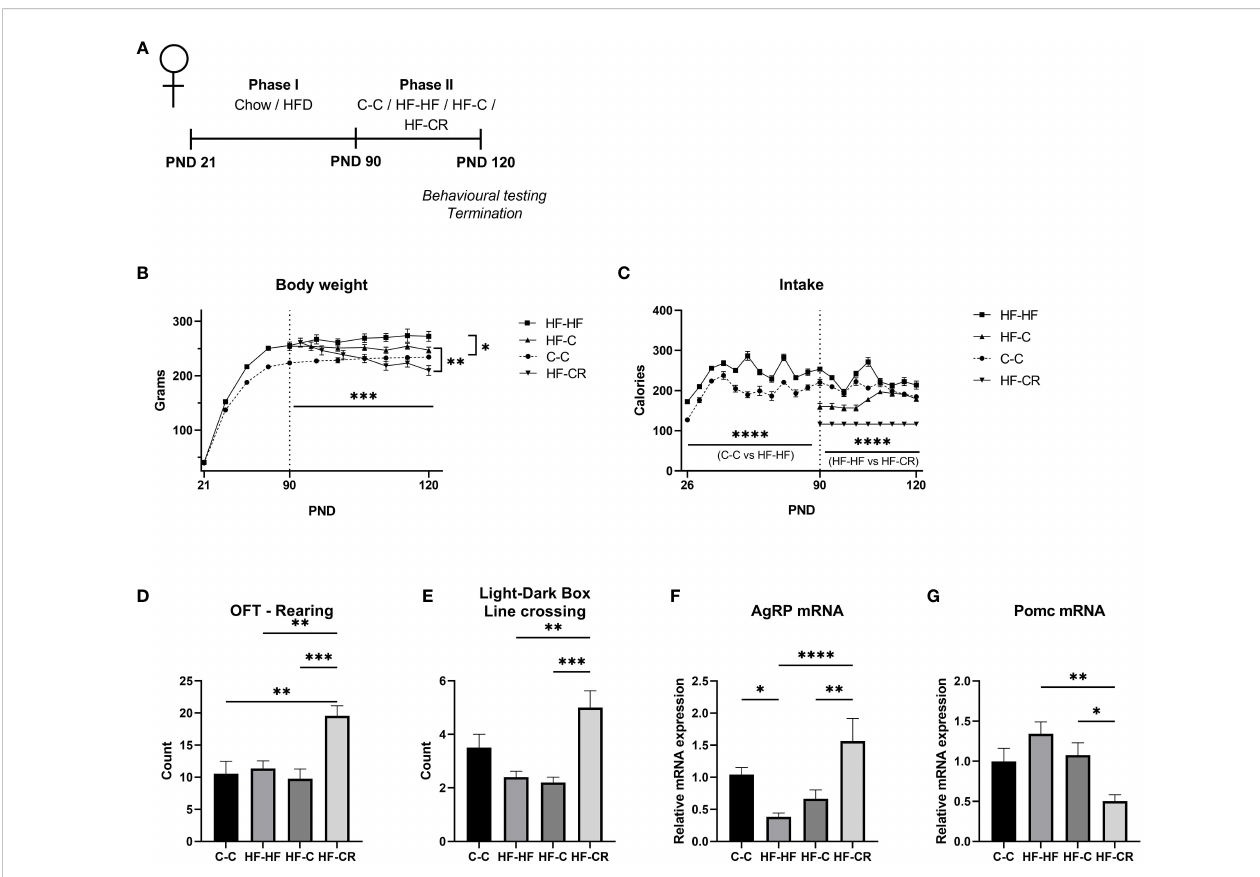
FIGURE 1 Caloric restriction results in reduction of body weight, increased explorative behaviours and changes in classic-energy balanced gene expression in the ARC of diet-induced obese female rats. (A) Experimental timeline. In Phase I (PND 21-90), rats were raised on either chow (n= 24) or HFD (n= 72). In Phase II (PND 90-120) rats were assigned to various treatment groups (n=24), with body weight normalized between the HFD groups. C-C (Chow- Chow) group maintained an ad libitum chow diet, HF-HF (HFD-HFD) group maintained an ad libitum HF diet, HF-C (HF-Chow) group switched from ad libitum chow to HFD and HF-CR (HFD-Caloric Restriction) group switched diet from ad libitum HFD to a 60%-calorically restricted diet of chow. At PND 120, rats were subjected to the Open Field Test and the Light-Dark Box test before termination of experiment. (B) The average body weight (grams) throughout the duration of the experiment. In Phase I, rats were weighed every 5 days and weighed daily in Phase II (C) Average caloric intake (kCal) throughout the duration of the experiment, measured by the weight difference of food remaining in the cages over 5 days during Phase I and daily